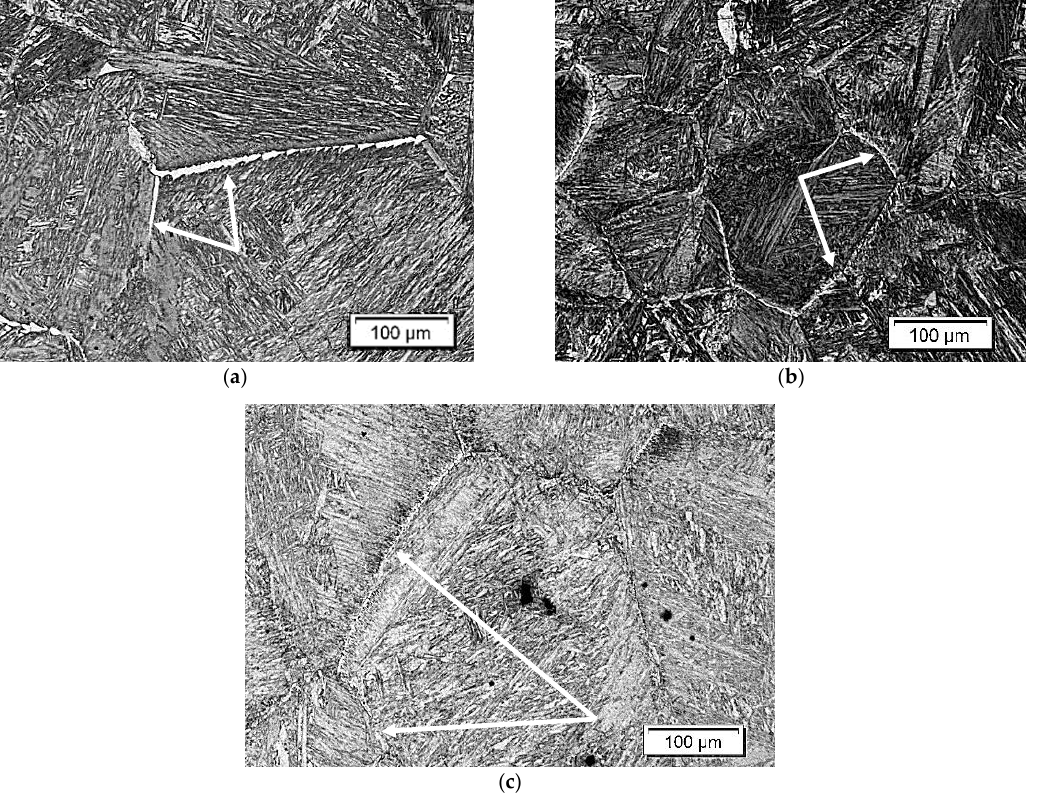
Figure 4. Microstructures of specimens quenched from ( a ) T min = 730 °C before rebounding, and from a T max of ( b ) 830 °C and ( c ) 1130 °C. The thin ferrite films (arrows) get thinner with increasing T max .